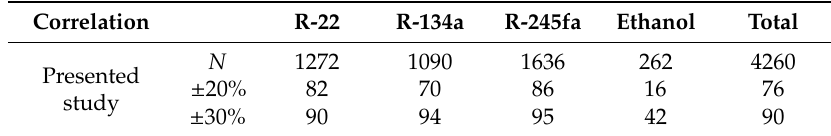
Table 10. The predictive ability of the proposed correlation for heat transfer coe ffi cient of supercritical organic